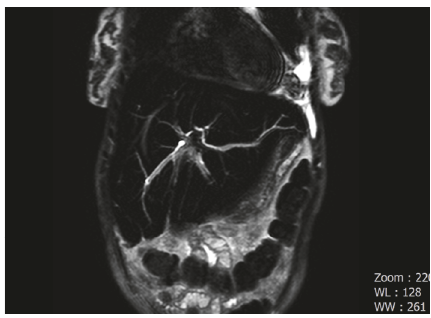
Figure 4: Coronal image of an MRCP showing an isolated left intrahepatic duct extending through the left hepatic lobe to the left costophrenic angle.